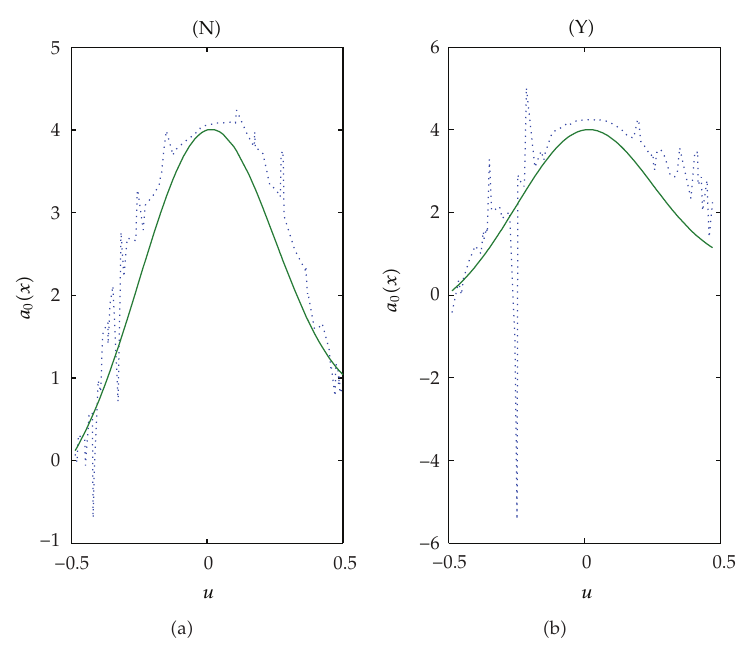
Figure 4: Simulation results for (cid:4) a 0 (cid:3) x (cid:4) . Dotted curves are L 2 estimators; solid curve are the true curves. (cid:3) N (cid:4) plot without outliers, (cid:3) Y (cid:4) plot with three outliers (cid:3) x,y (cid:4) (cid:5) (cid:3) − 0 . 4538 , − 5 (cid:4) , (cid:3) 0 . 1948 , 8 (cid:4) , and (cid:3) 0 . 4649 , 5 (cid:4)